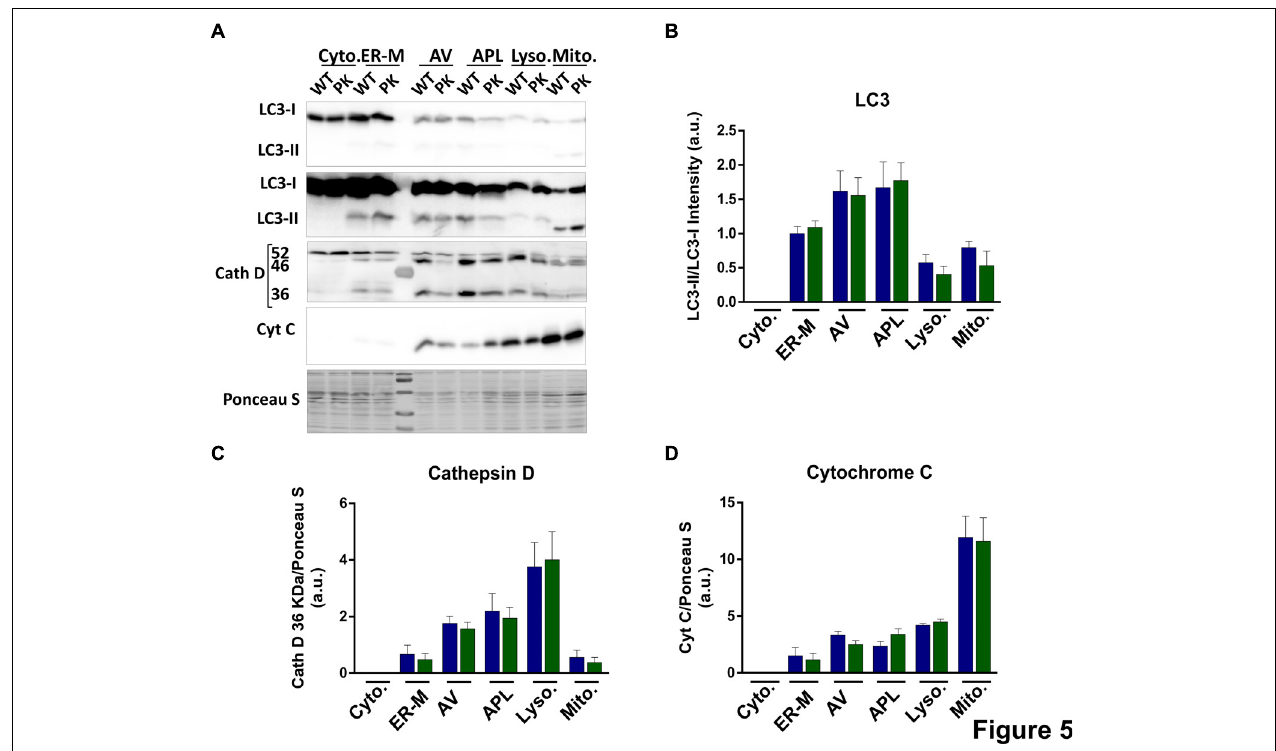
FIGURE 5 | Enrichment of autophagosomes, lysosomes and mitochondria from mice’s brain. Parkin loss doesn’t impair autophagic processes in the young animals. (A) Representative images of Western-Blot experiments showing LC3 (LC3-I and LC3-II), ( ∗ higher exposure in the bottom image), Cathepsin D (52, 46, and 36 KDa) and Cytochrome C levels in the different subcellular fractions isolated. (B) Quantification of LC3-II/LC3-I ratio. (C) Quantification of mature Cath D 36 KDa in brain’s subcellular fractions. (D) Quantification of Citochrome C signal intensity in brain’s subcellular fractions. Graphs represent the mean ± SEM. Statistical analysis was performed by One Way ANOVA test. n = 3–5 preparations of three mice